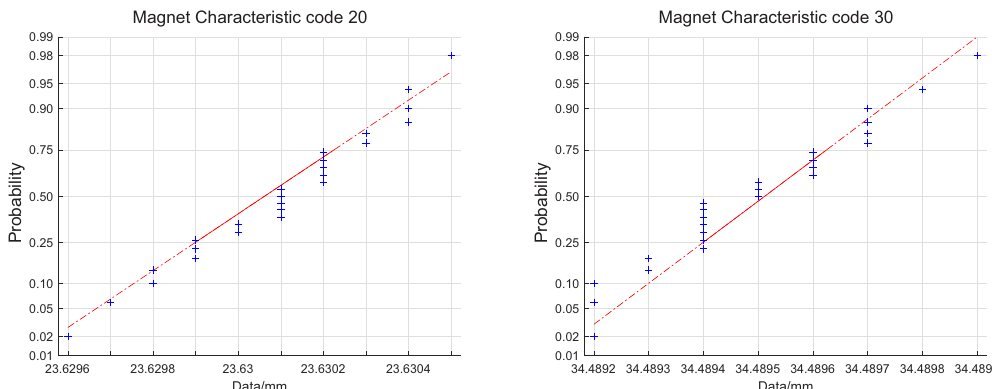
Figure 6. Normal probability plot for measurement codes 20 and 30 of Magnet object for measurements of one repetition for measurement scenario 1 (n = 25). Calculated p-values using Anderson Darling normality test are, respectively, 0.910 and 0.754.